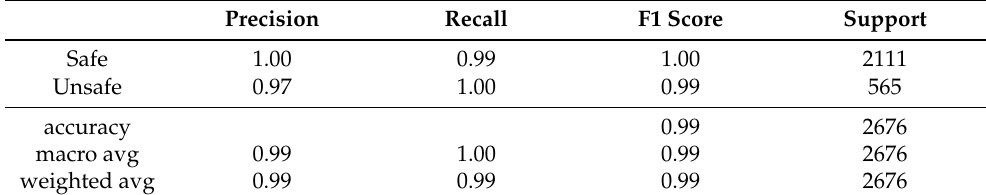
Table 7. Binary Classification report of VulEye.